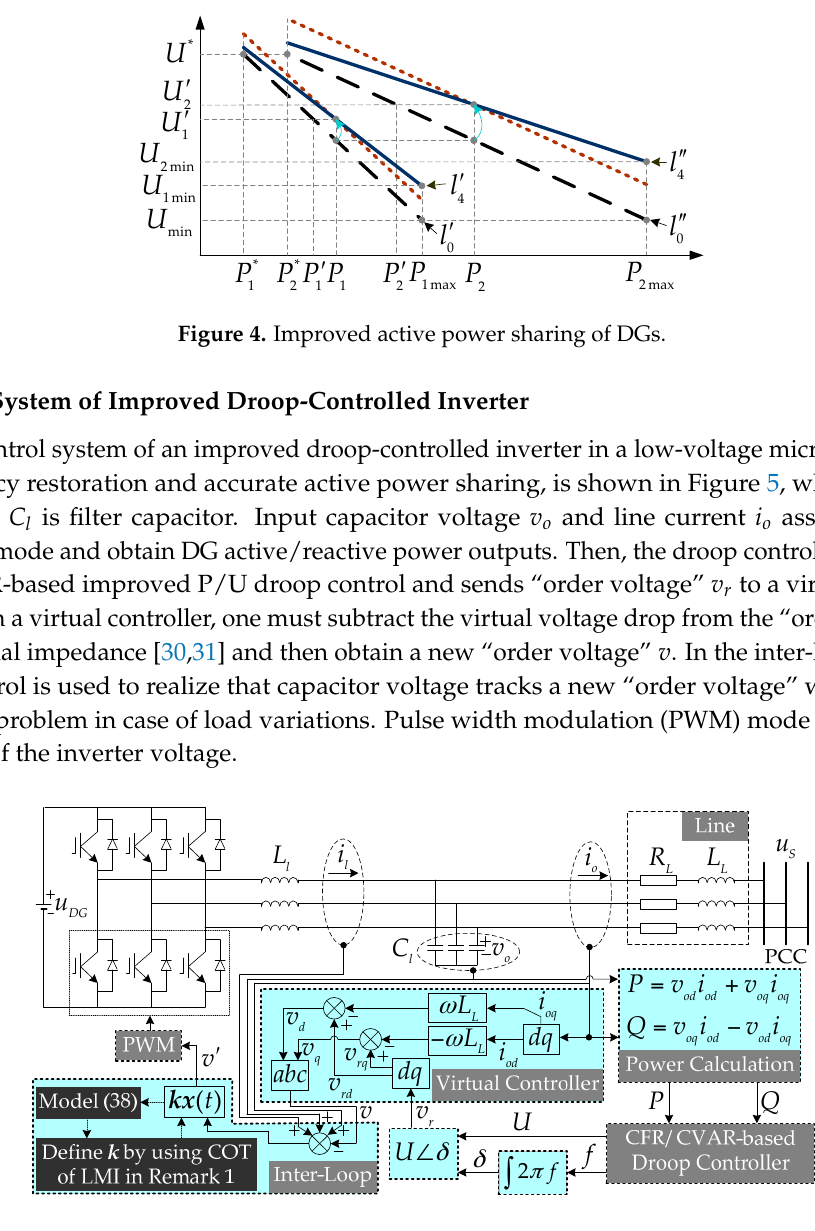
Figure 5. Improved control system of DG in low-voltage microgrid.